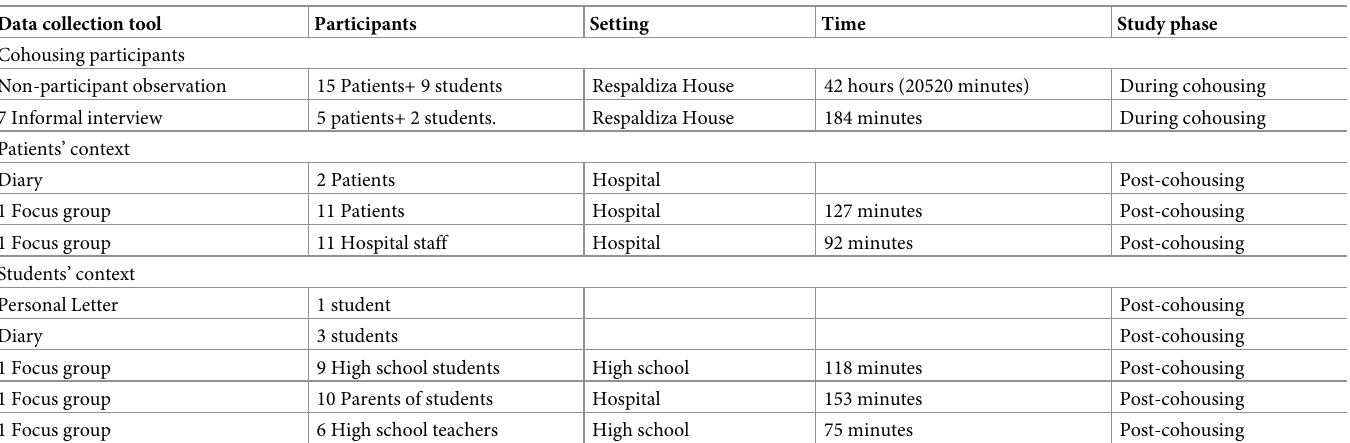
Table 2. Data collection